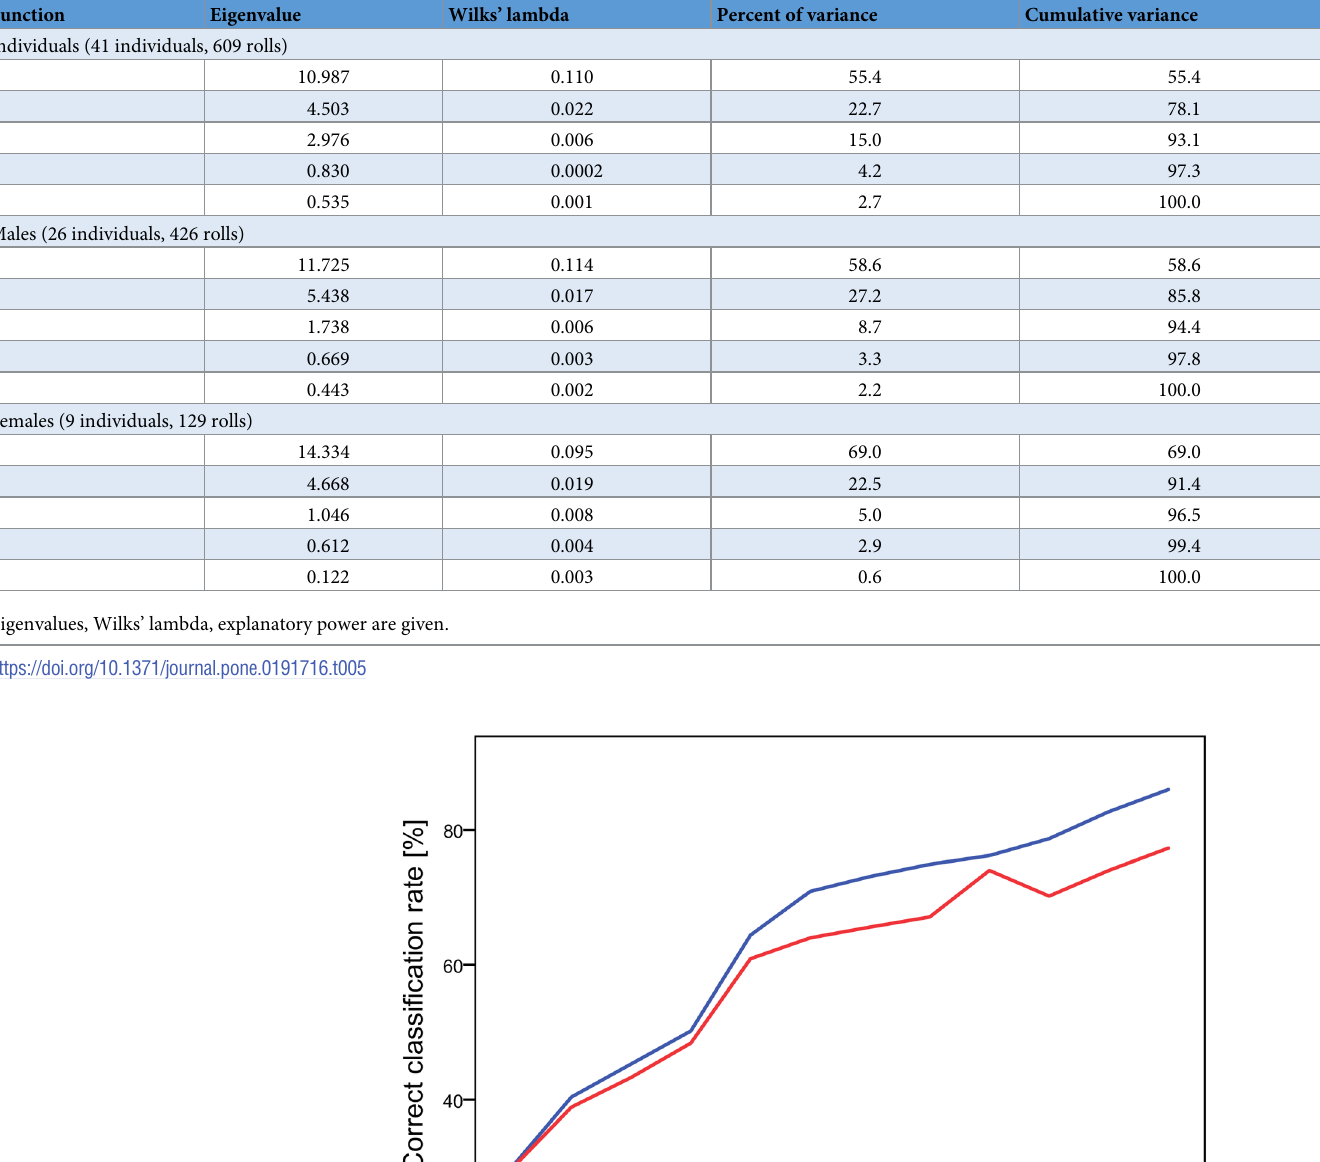
Table 5. Results of three DFAs, which classify drumming of individuals, males and females. Function